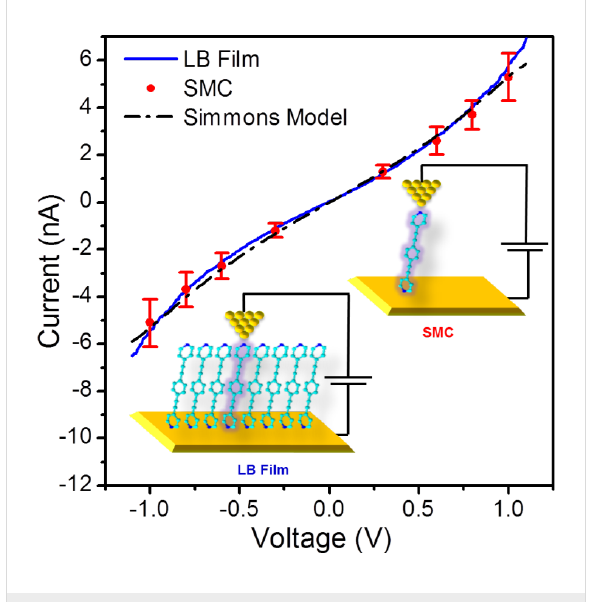
Figure 8: I–V curve of a single layer LB film of 1 transferred onto Au(111) at a surface pressure of 16 mN·m − 1 using I 0 = 2.5 nA and U t = 0.6 V as set-point parameters (blue line) and fitted according to the Simmons equation using φ = 0.71 eV, α = 0.35 (black dashed line). An I–V curve constructed from single molecule conductance values obtained using the I ( s ) method is also shown (red circles). The error bars represent the standard deviation obtained from the widths of the conductance histogram